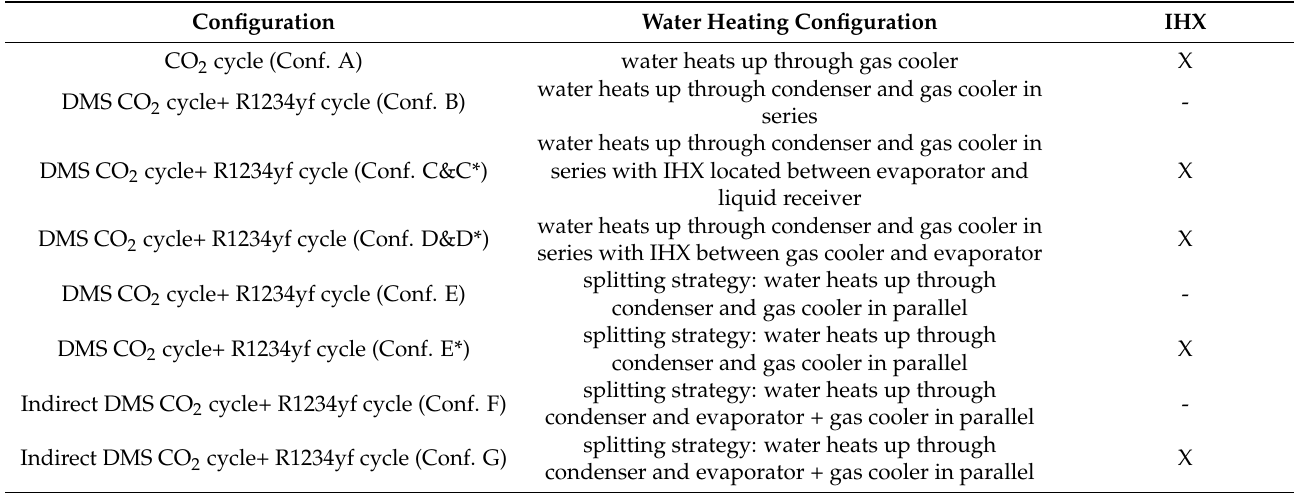
Table 2. Characteristics of the configurations